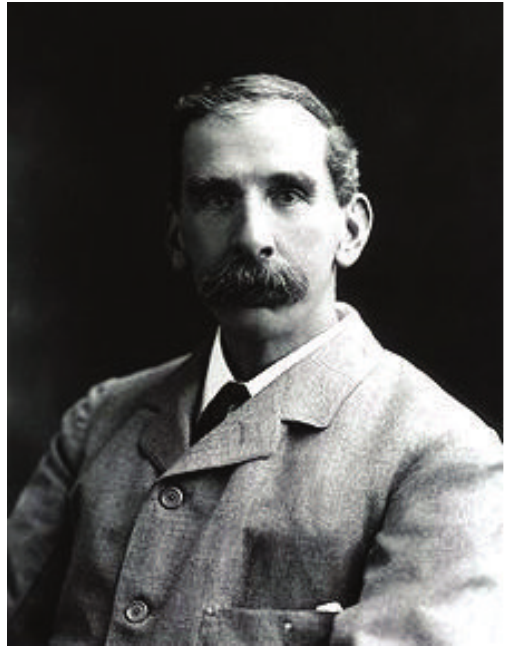
Figure 2: Sir William Horsley